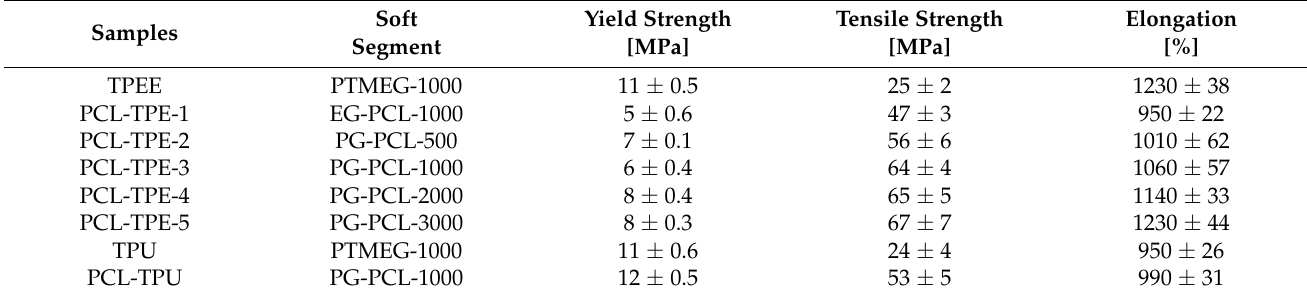
Table 6. Mechanical properties of the resultant TPEs and TPUs 1